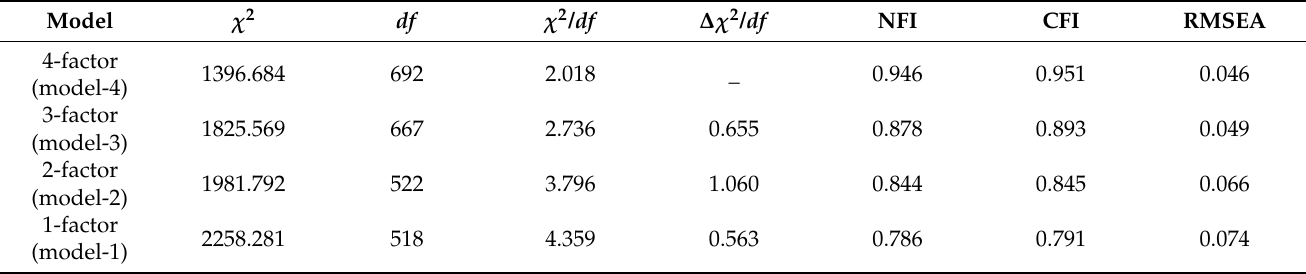
Table 4. Model fit comparisons of alternate vs. hypothesized